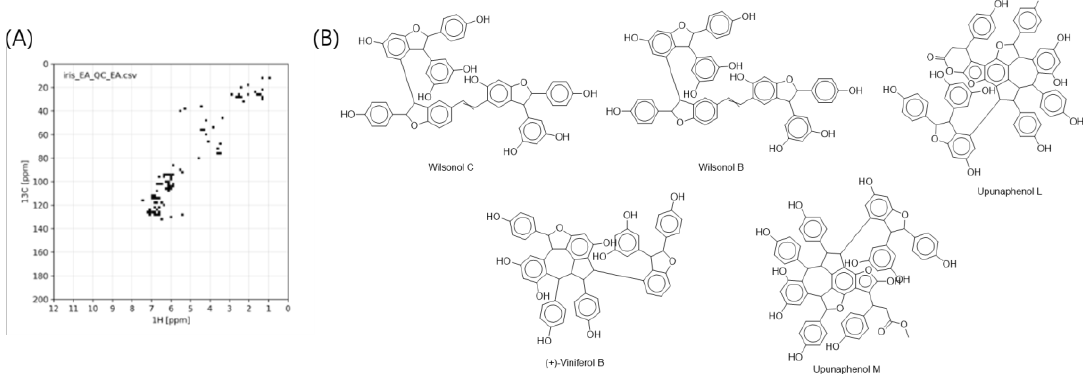
Figure 2. Digitized HSQC (heteronuclear single quantum coherence) spectra of ethyl acetate extracts of I. lactea ( A ) and their top 5 annotated structures from SMART analysis ( B ). Annotated structures were filtered by the molecular weight range of 600–1200 Da.